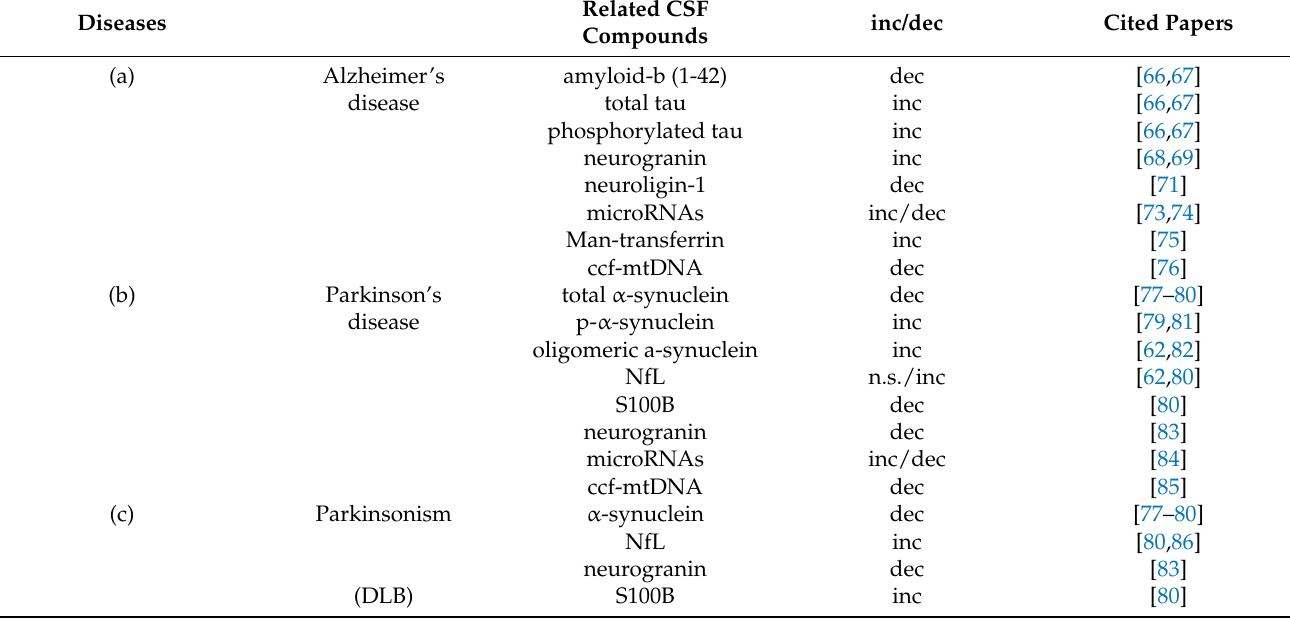
Table 4. CSF compounds of neurodegenerative